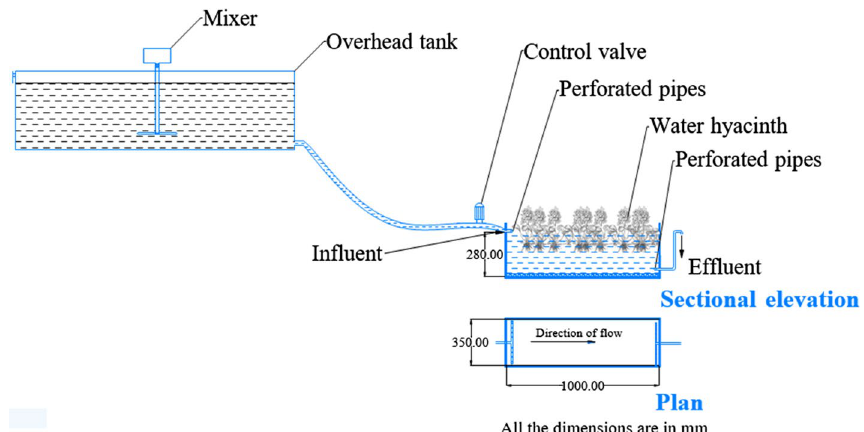
Fig. 1 Sectional elevation and plan view of the experimental setup for greywater treatment